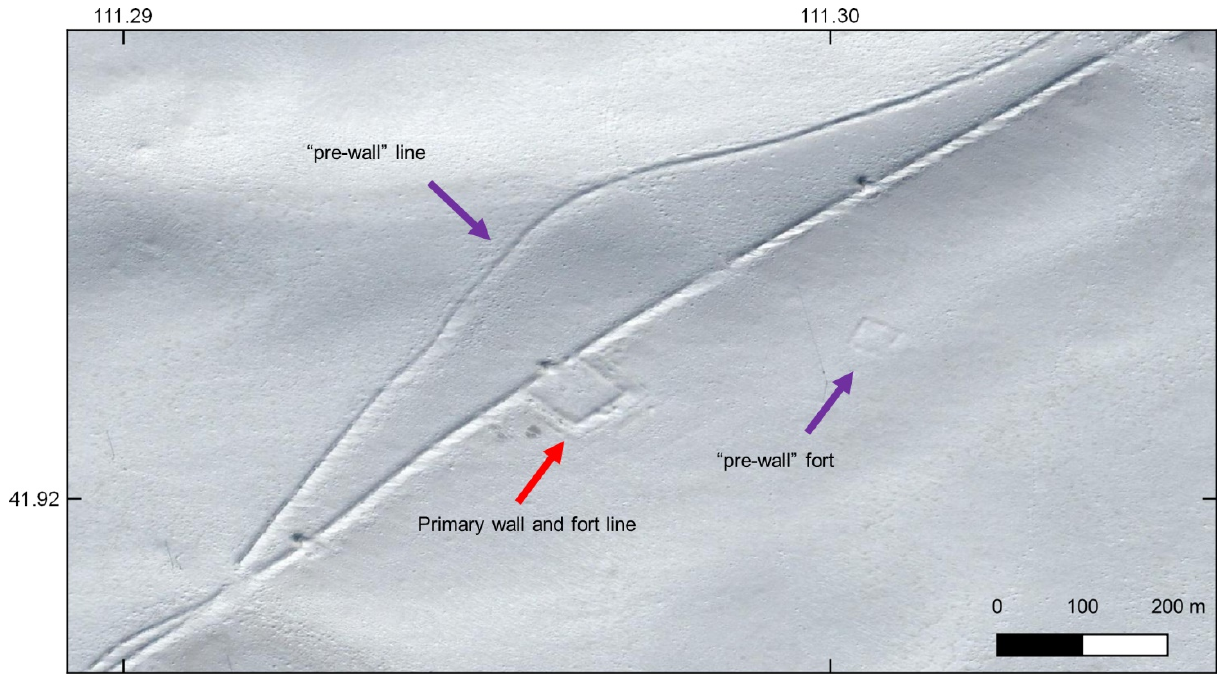
Figure 12. Examples of the main line with forts and bastions repurposing the “pre-wall” wall line and forts.